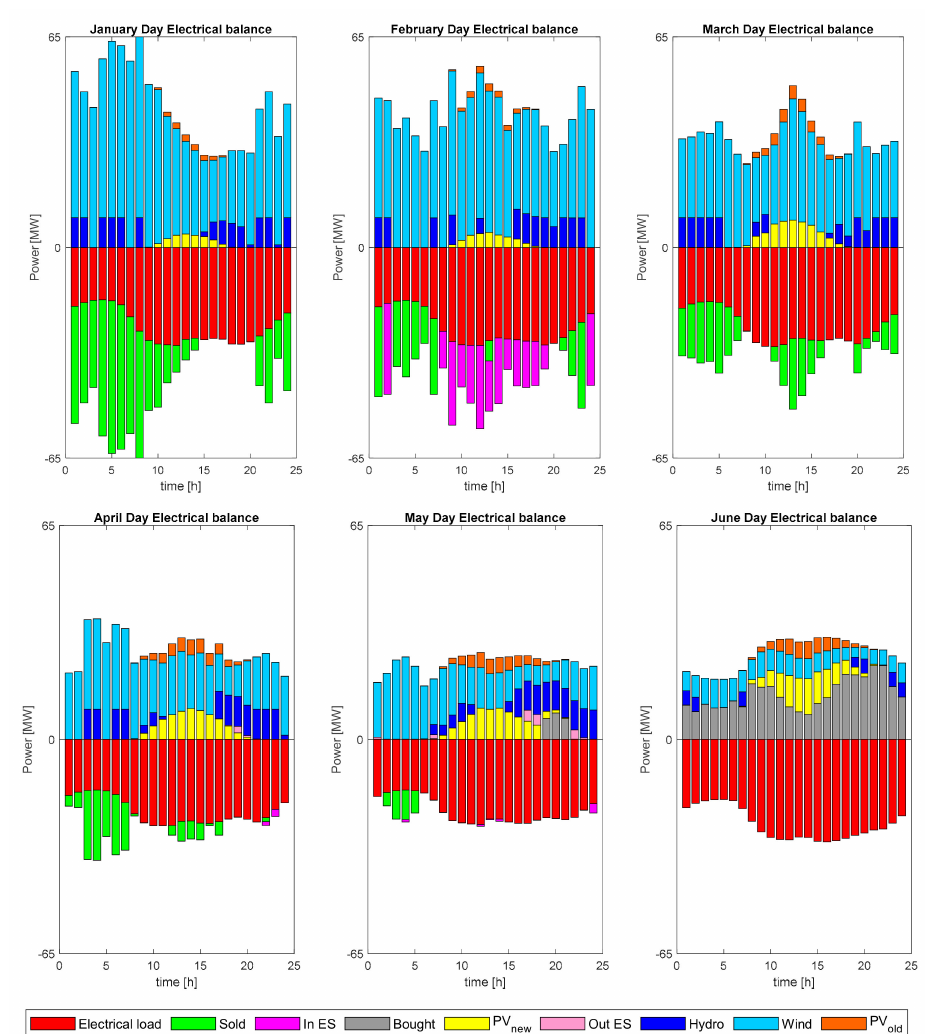
Figure 6. Optimal daily scheduling from January to June typical